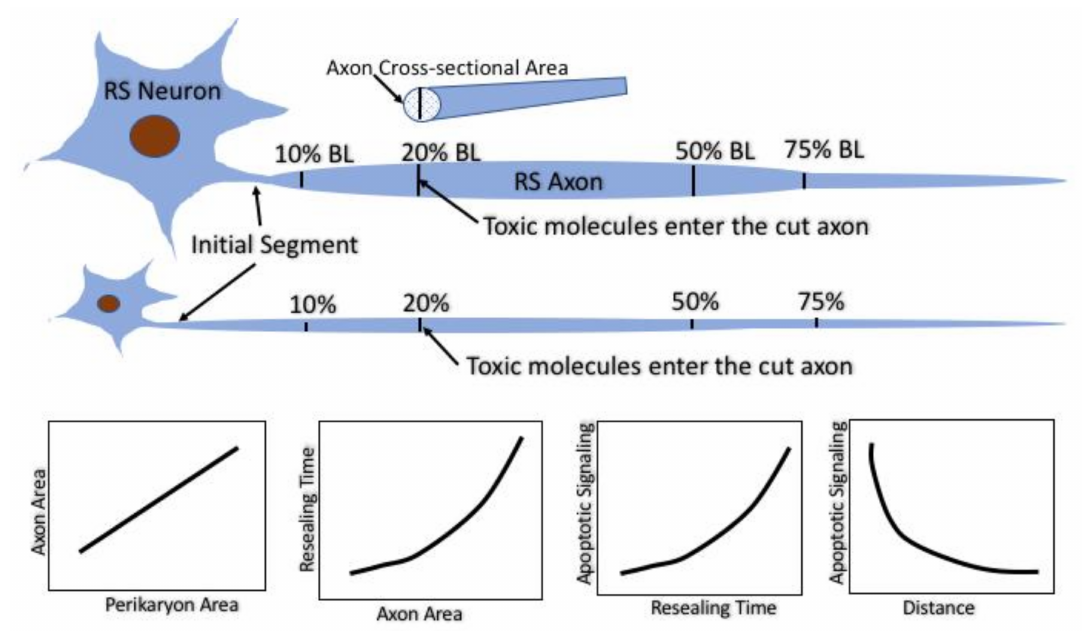
Figure 12. Summary of the experimental strategy and main conclusions. The identified RS neurons in the lamprey vary in size but project along almost the entire length of the animal. Their axon calibers are tightly correlated with their perikaryal size. Spinal cord TX at very rostral and very caudal levels results in axotomy where the axons are narrow and therefore seal rapidly. TX at 20% or 50% body length axotomizes the same axons at levels where their calibers are larger and they seal more slowly. At any TX level, the larger the neuron and its axon, the longer it takes for its axon to seal. The longer the sealing time, the more likely it is that the perikaryon will undergo delayed retrograde cell death. However, for any neuron, the further the TX from its perikaryon, the less likely it is that it will undergo cell death. Thus, the distance influences retrograde apoptosis independently of the sealing